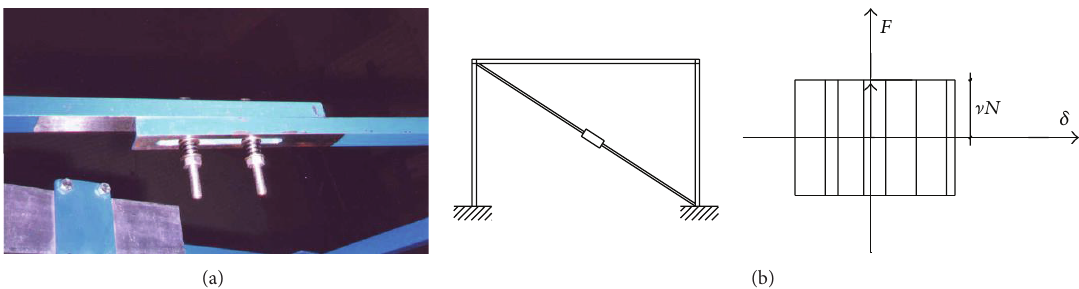
Figure 2: Friction damper utilized in the dynamic tests. (a) Detail of the dissipation node. (b) Force-displacement (𝐹 - 𝛿)